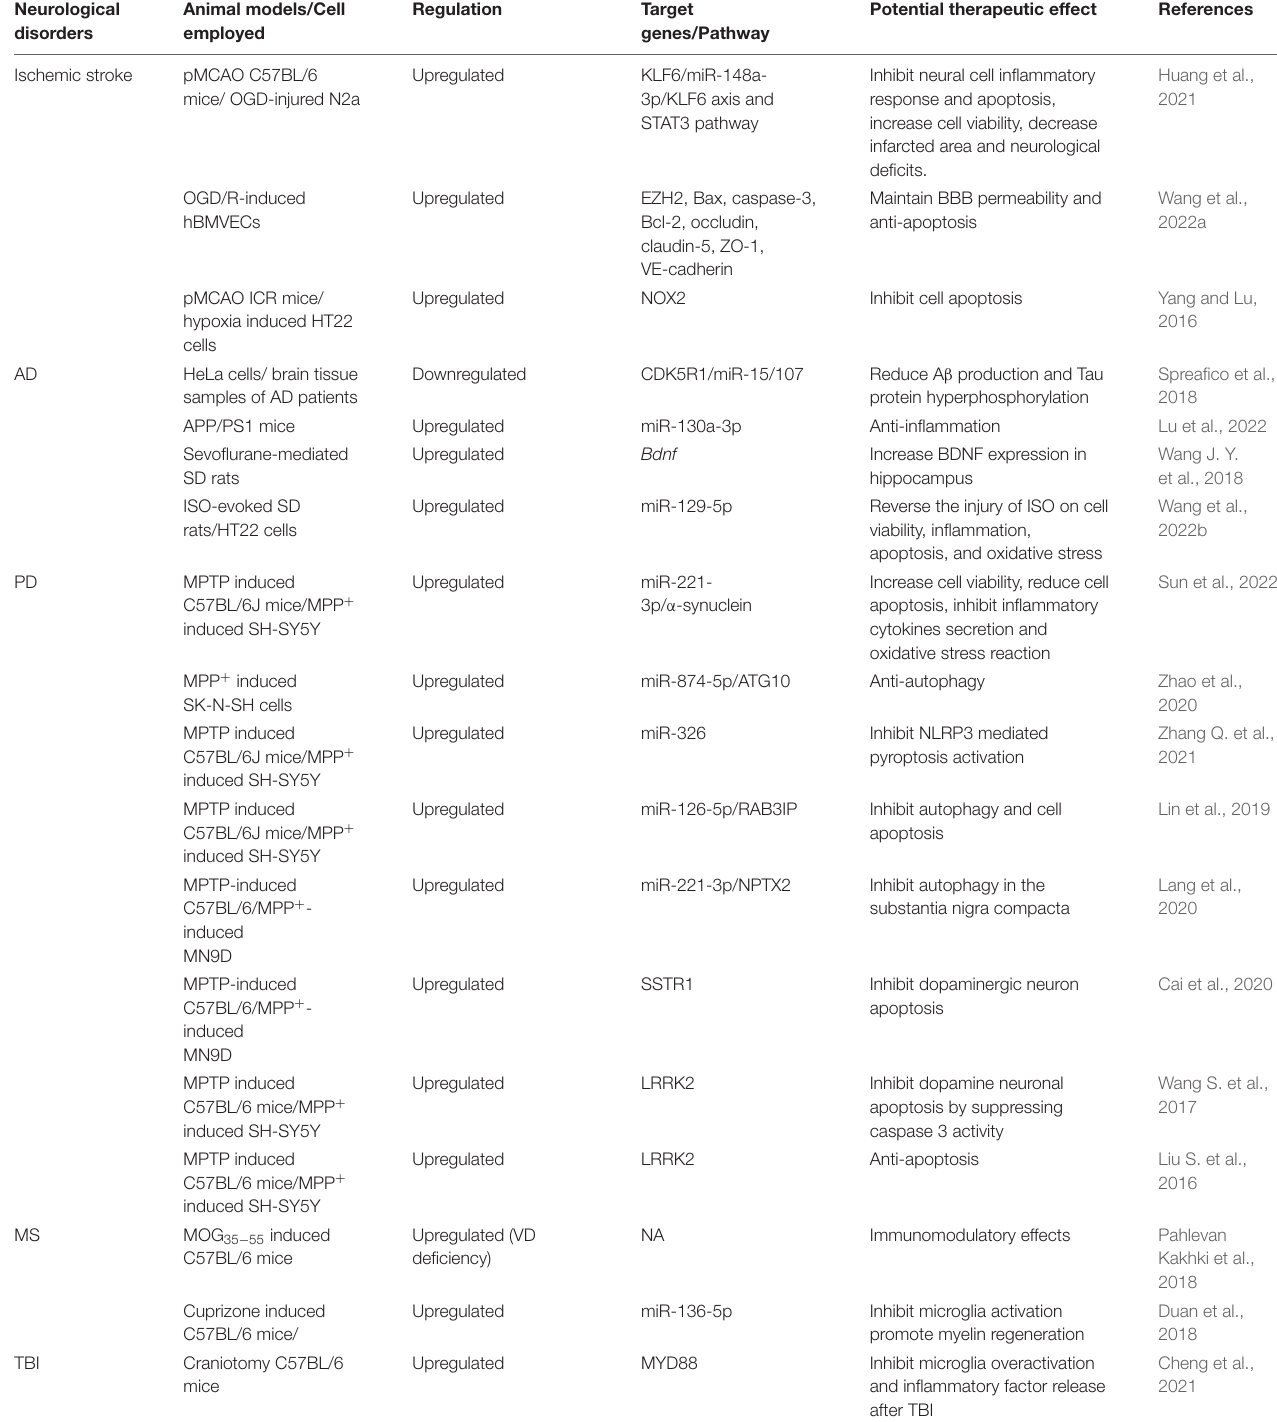
TABLE 1 | Role of HOTAIR in CNS